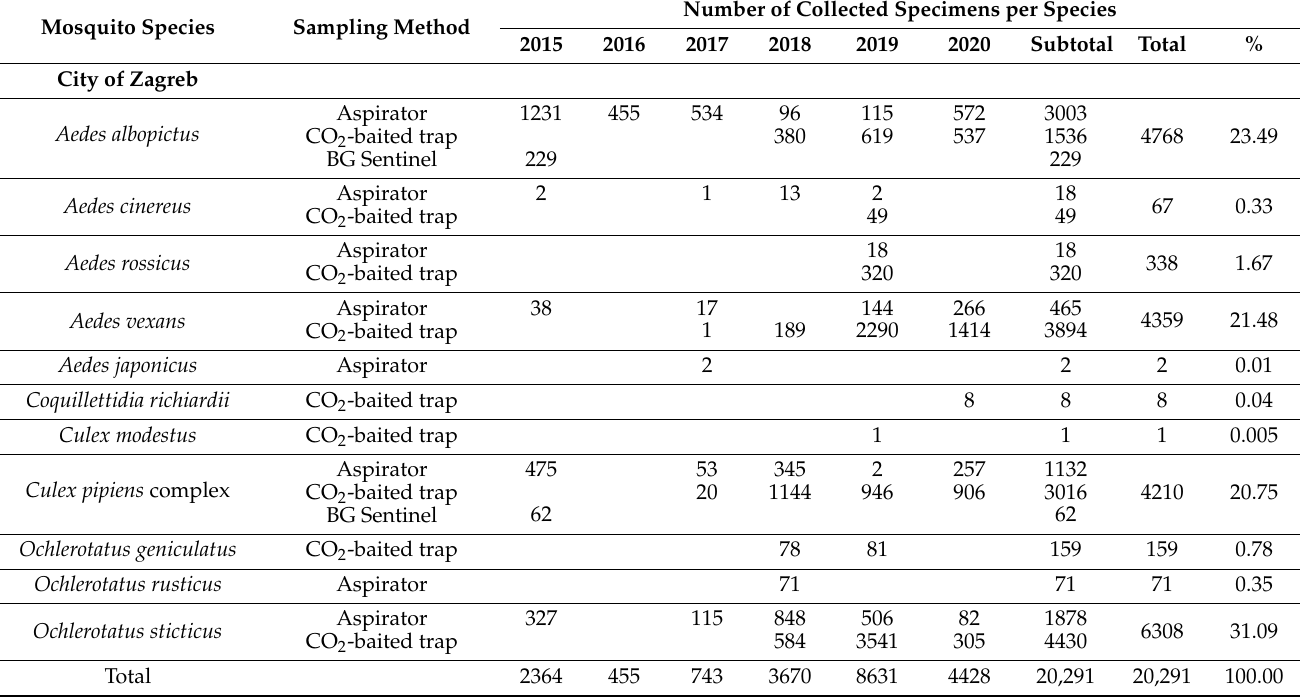
Table 2. Number of collected mosquitoes by species and sampling